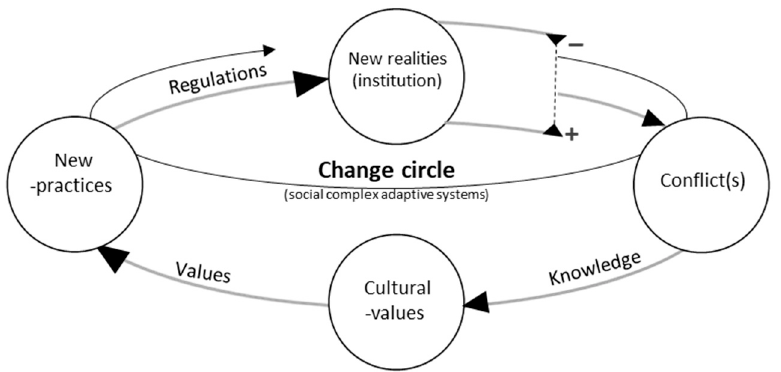
Figure 4. Circulation of change and adaptation in social systems. Conflict, by diffusion of new knowledge, becomes an agent for the change in deep culture and culture. By reframing values, it becomes an agent of the change to new realities (e.g., emerging new institutions) in social systems. Despite this, the success of conflict (as a process of change), i.e., whether it has created new synergies or not, is partly about the rigidity and resistance of culture